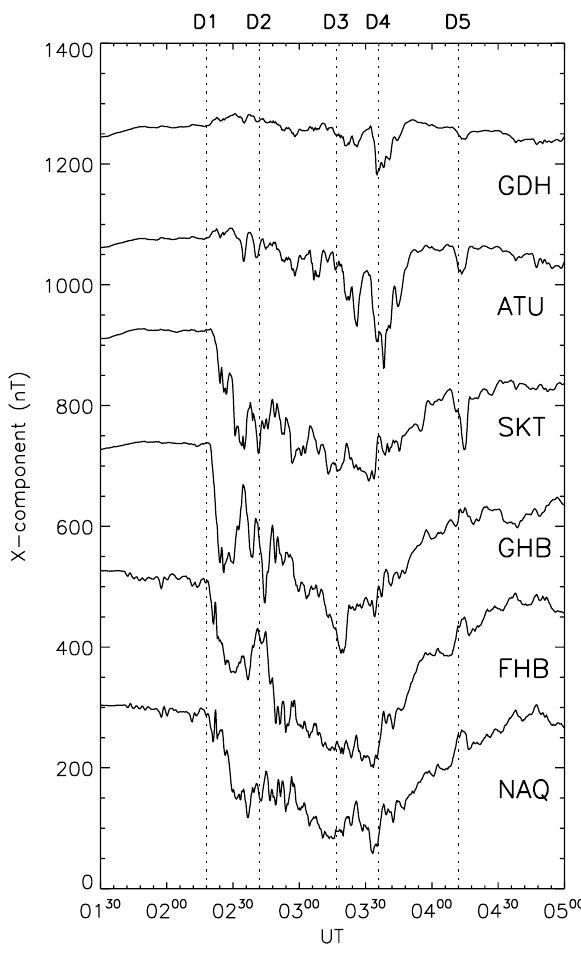
Fig. 5. X-component magnetograms from the Greenland West Coast magnetometer chain for the interval 01:30 to 05:00 UT, 29 August